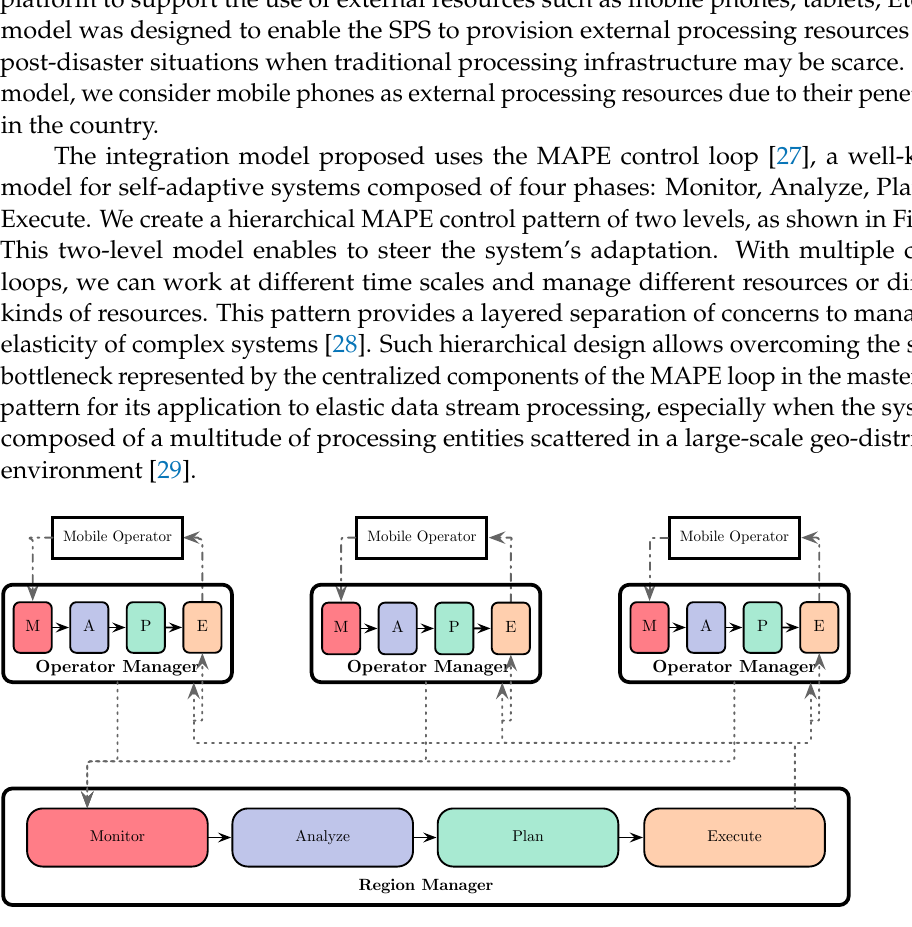
Figure 1. Hierarchical integration model with MAPE control